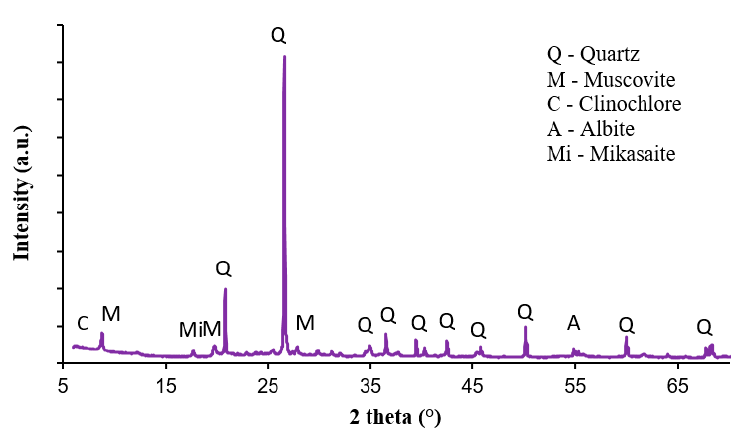
Figure 6. X-ray diffraction (XRD) patterns of brick soil. Figure 6. X-ray di ff raction (XRD) patterns of brick soil.